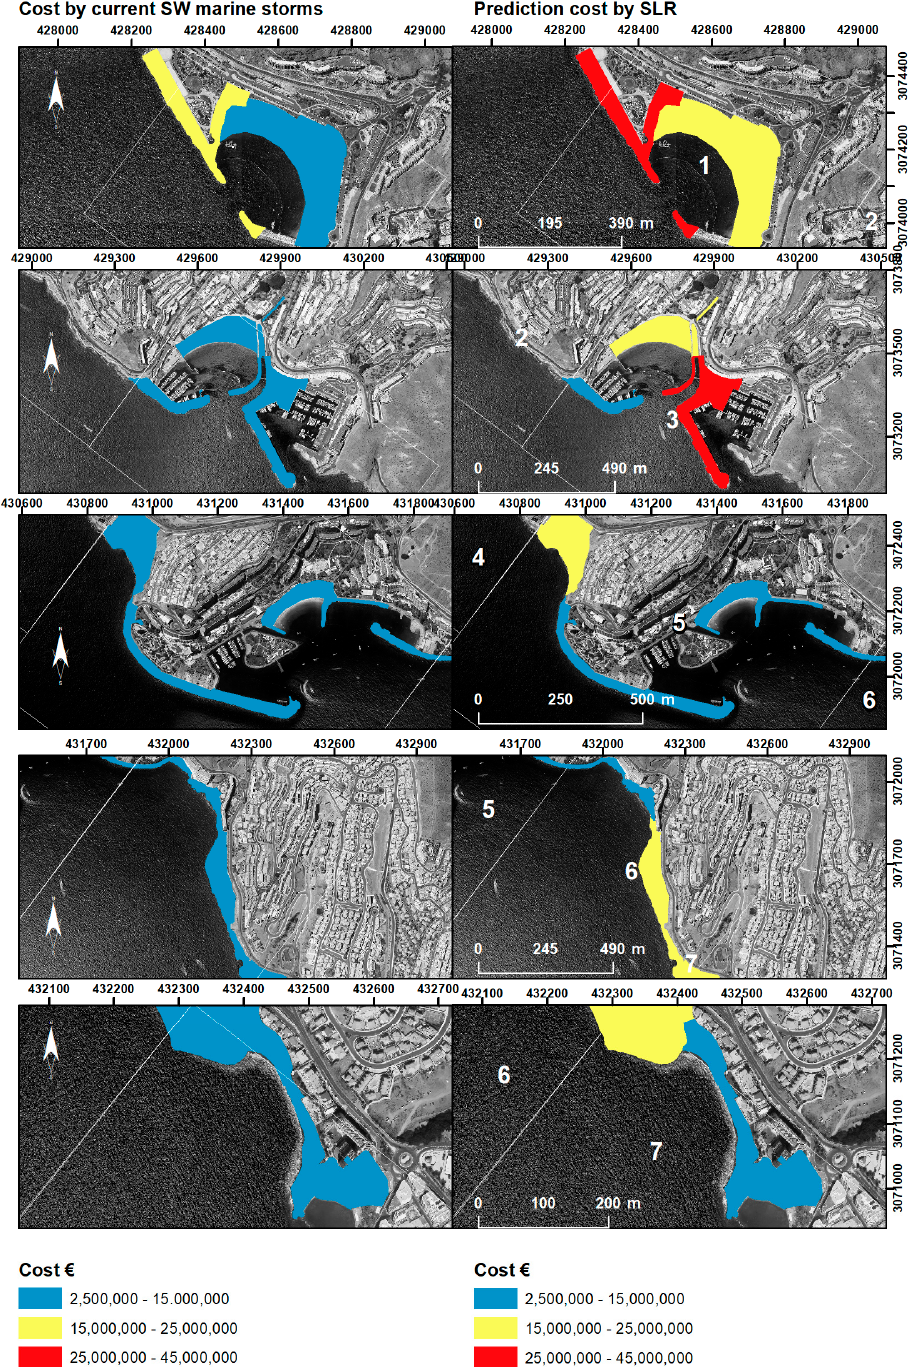
Figure 10. Economic cost of infrastructures and beaches affected by SW sea storm events, with current climate ( left ) and RCP 8.5 scenario ( right ) in the study area for the studied period.